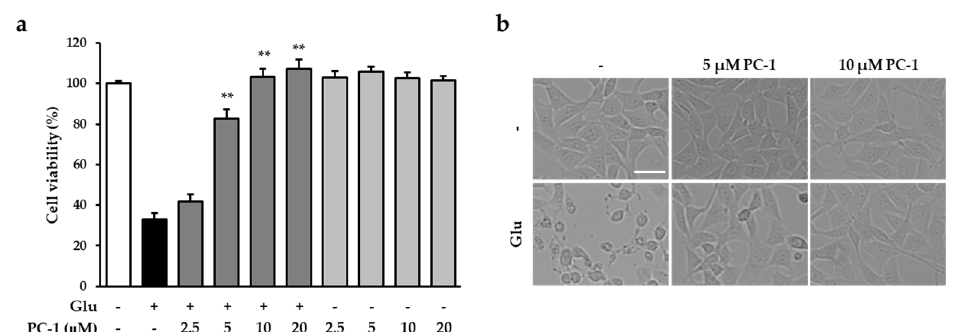
Figure 2. Neuroprotective effects of PC-1 isolated from grape seed in HT22 cells. ( a ) The cells were treated with 5 mM glutamate and the indicated concentrations of PC-1. Data are presented as the mean value ± S.E.M. ** p < 0.001 versus glutamate-treated HT22 cells. ( b ) Representative microscopic images were obtained. Scale bar, 50 µm.